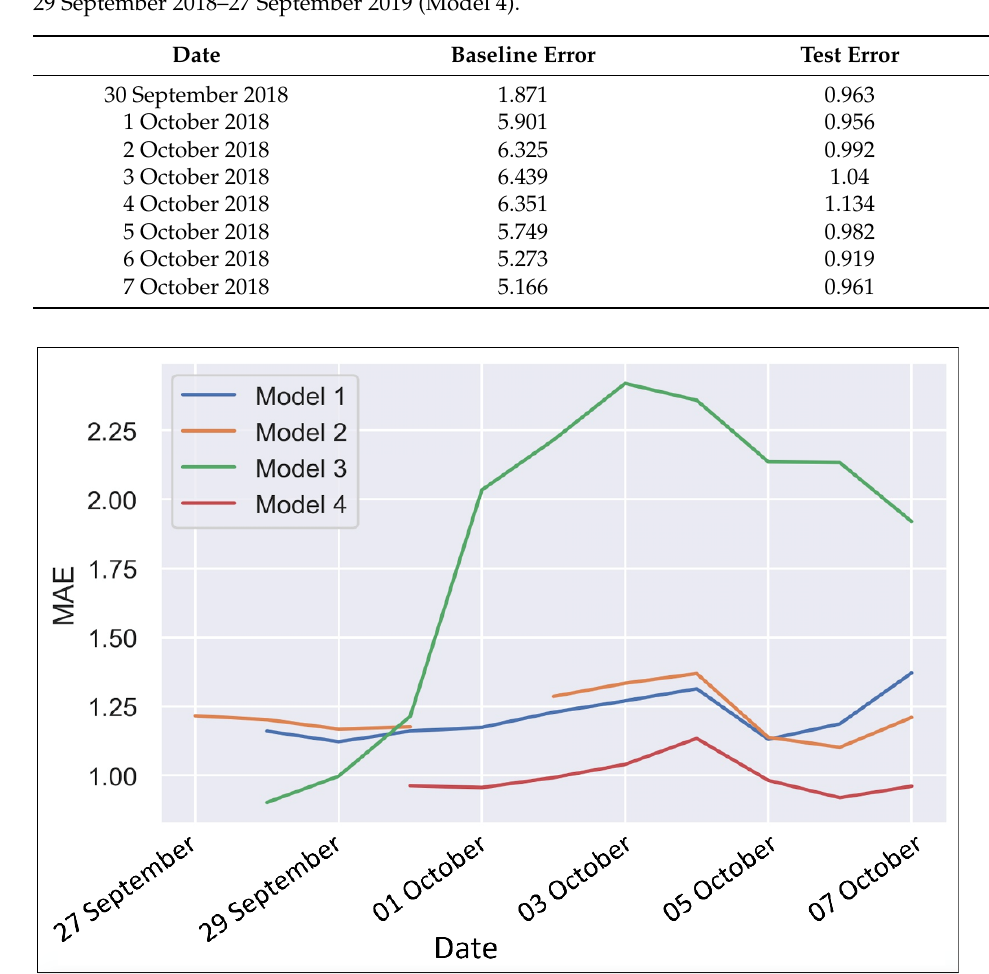
Table 5. Errors on the entire test set of the 22-parameter model by 1 h granularity during 29 Sep-